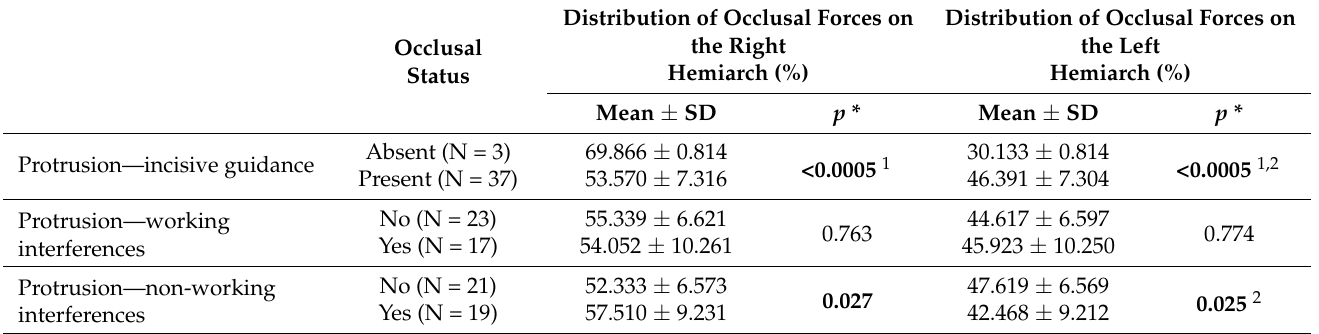
Table 7. Distribution of occlusal forces at the level of the two hemiarches in the MI position, ac- cording to the presence of the incisal guidance, the presence of working and non-working occlusal interferences in the protrusion